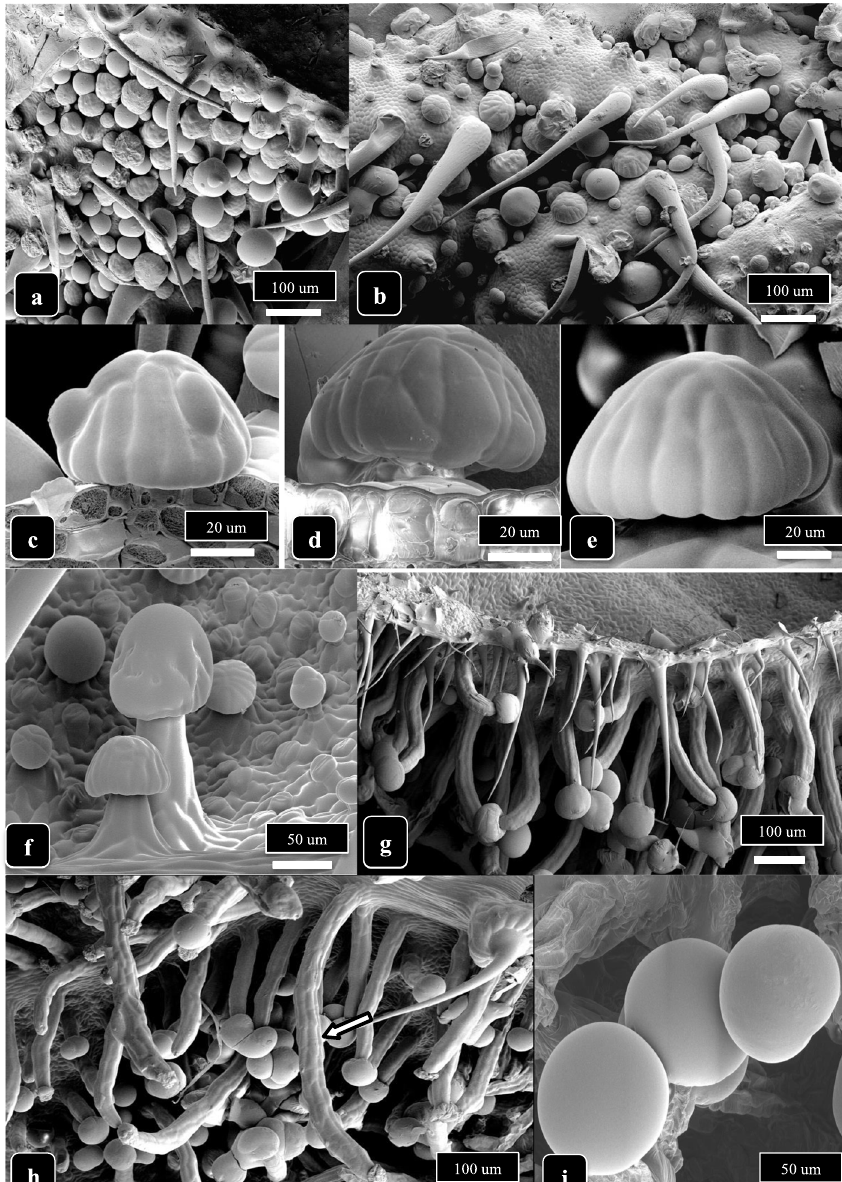
Fig. 4 Capitate trichome development on cannabis strain SQ, lower bract surface, at 3 and 6 weeks of inflorescence development. a At 3 weeks, most capitate trichomes at the tip of the bract are sessile. b Close-up view showing a mixture of sessile-capitate trichomes with bulbous trichomes and nonglandular hairs. There are no stalked-capitate trichomes. c – e Presecretory (sessile) trichomes showing the outlines of presecretory disc cells. f A range of stalk lengths have developed on capitate trichomes, and sessile trichomes can be seen in the background. g At 6 weeks, stalked-capitate trichomes are densely packed together on the underside of the bracts and have formed long stalks. h Some stalked-capitate trichomes that form at the edge of a bract have extremely long stalks, up to 1000 μm (arrow). i Magnified view of capitate trichomes showing fully formed heads surrounded by a